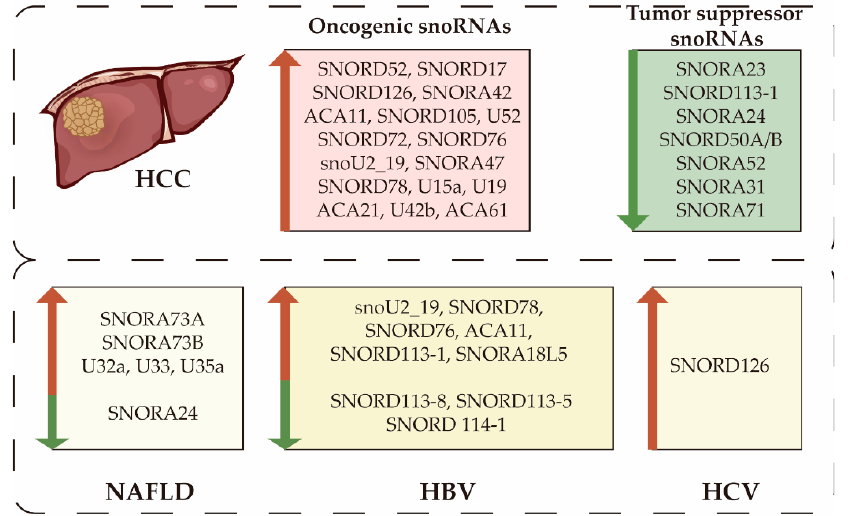
Figure 2. Dysregulated snoRNAs in hepatocellular carcinoma (HCC) and associated diseases.